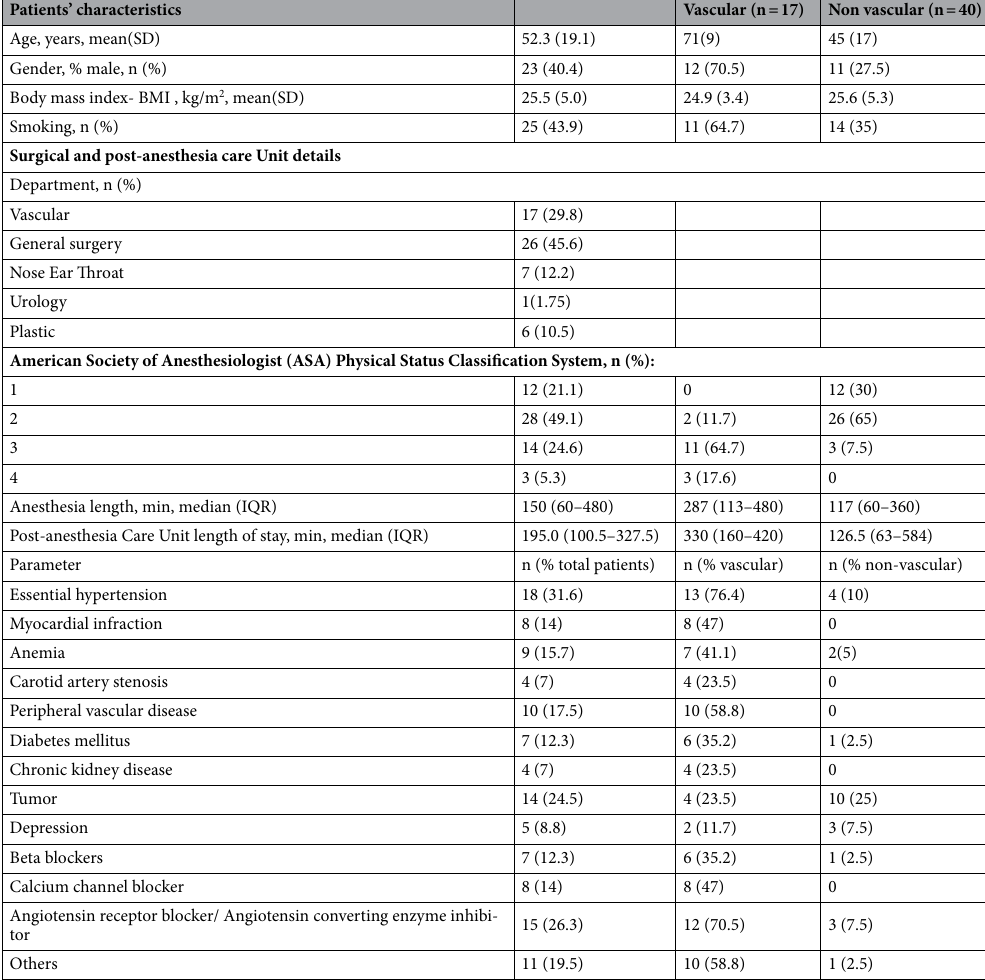
Table 1. Demographics, comorbidities & medications. Others: Congestive heart failure, cerebrovascular disease, chronic obstructive pulmonary disease, Hematologic tumor, Obstructive sleep apnea.